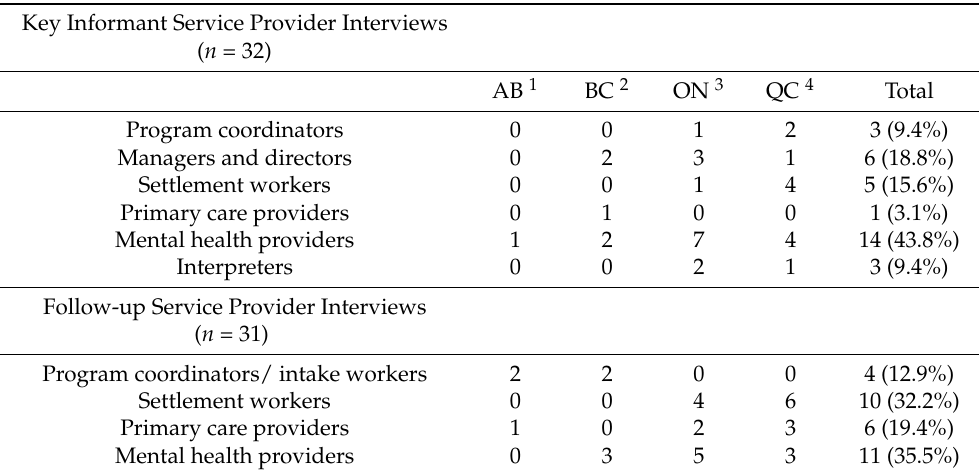
Table 1. Distribution of Service Providers’ Interviews by Province and Role.